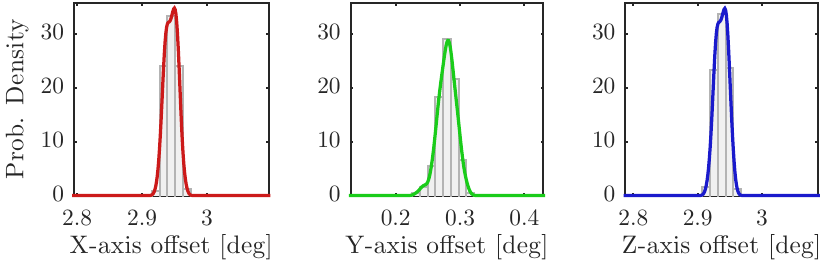
Figure 9. Calculated angular offset (measured between the ideal principal axes and measured principal axes) for 200 measurements of the pole-shoe TCP using the touch probe (Sensor